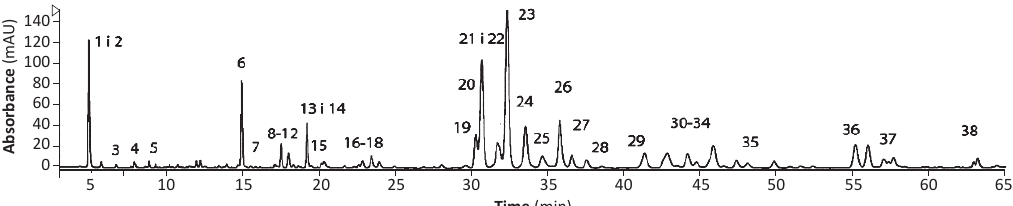
FiGURe 1. DAD chromatograms of identified resin compounds measured on 280 nm, 65 minutes. Peak numbers refer to those reported in Table